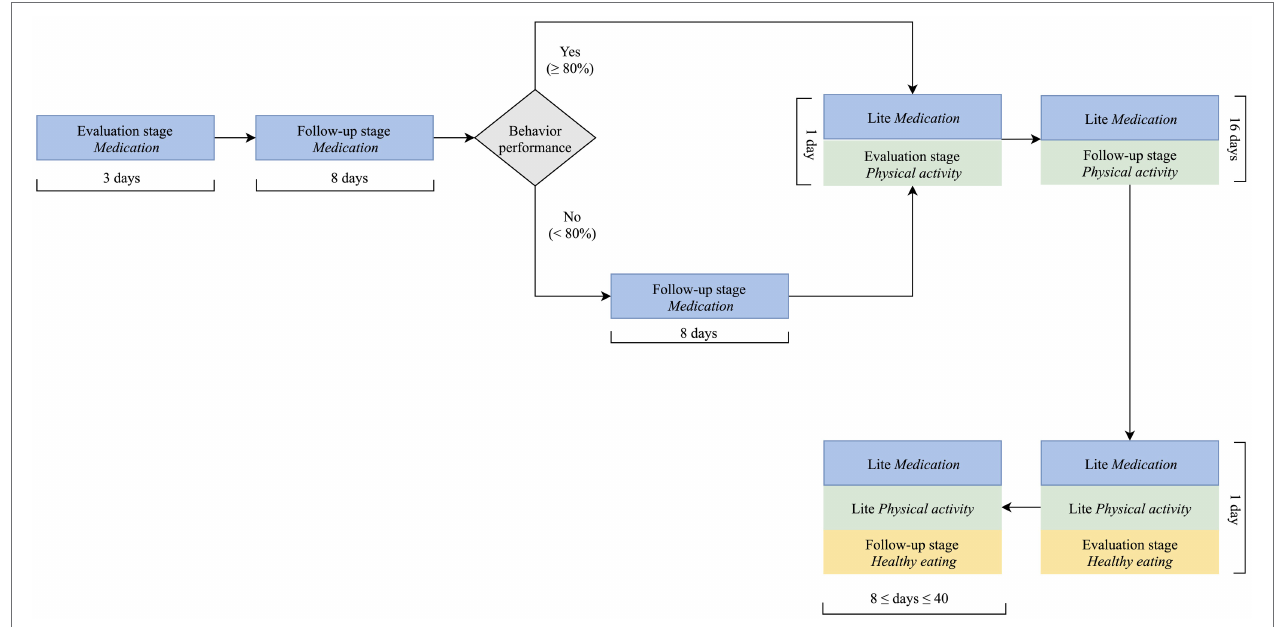
FIGURE 2 | Multi-behavior intervention design (assumption: one interaction per